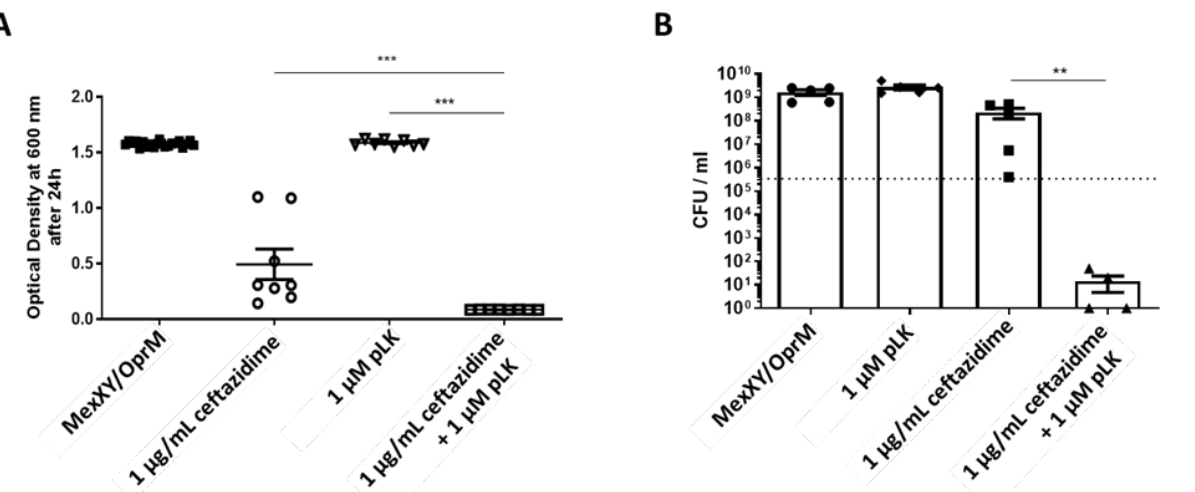
Figure 6. In vitro synergistic effect of the combination of pLK and ceftazidime on a P. aeruginosa strain overproducing MexXY/OprM. ( A ) Bacteria (1 × 10 5 /mL in exponential phase) were incubated at 37 °C in Mueller – Hinton medium in the presence or absence of 1 µM pLK, 1 µg/mL ceftazidime, or their combination. Bacterial growth was measured by monitoring the optical density at 600 nm after 24 h of incubation. ( B ) Determination of the colony forming unit (CFU)/mL was evaluated after 24 h of incubation. Values are mean ± SEM of five independent experiments. Statistical analysis was performed using the Mann–Whitney test (** p < 0.005, *** p < 0.0005). Next, we evaluated the ex vivo effect of the pLK/ceftazidime combination on MexAB- OprM overexpressing P. aeruginosa strains, using human PBEC maintained in ALI. Cells were infected by the MexAB-OprM strain at an MOI = 0.01. One hour later, the following treatments were applied: PBS, 2 μM pLK, 1 μg/mL ceftazidime alone, or in combination with pLK at the same concentrations. Twenty-four hours postinfection, the bacterial count was performed. Results revealed a synergistic effect for the combination of 2 µM pLK and 1 µg/mL ceftazidime (Figure 7), with a reduction in bacterial growth of 3-log 10 in compar- ison to the control (1 × 10 5 CFU/mL at the beginning of the experiment). Hence, the com- bination of pLK with ceftazidime or aztreonam could hinder the efflux pump-driven re- sistance of P. aeruginosa.